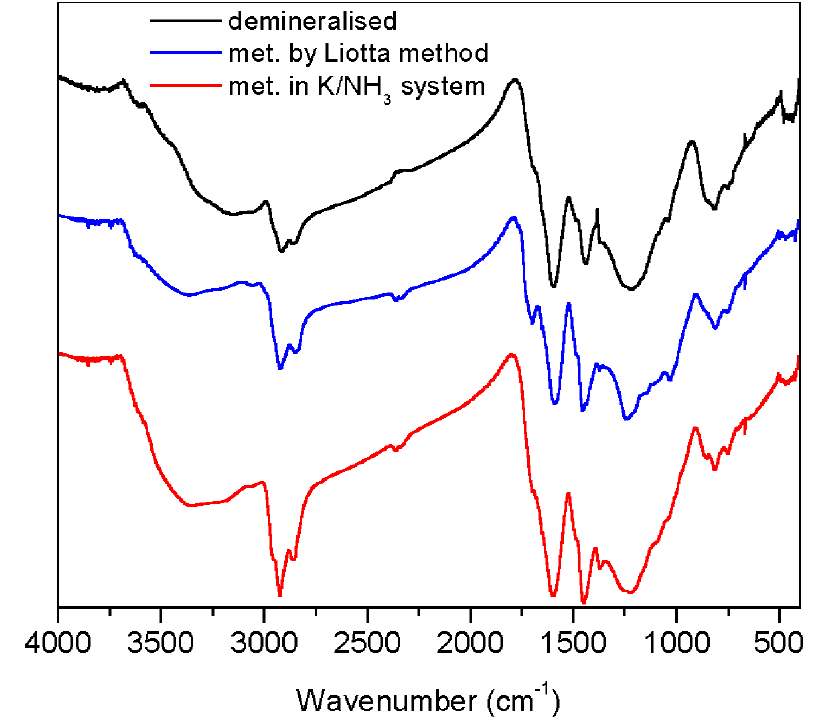
Fig. 4 IR spectra of CH 2 Cl 2 residues of Illinois No. 6